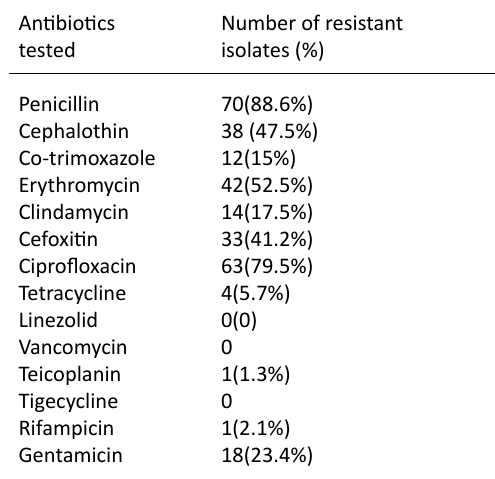
Table 1. Antibiotic resistance pattern in